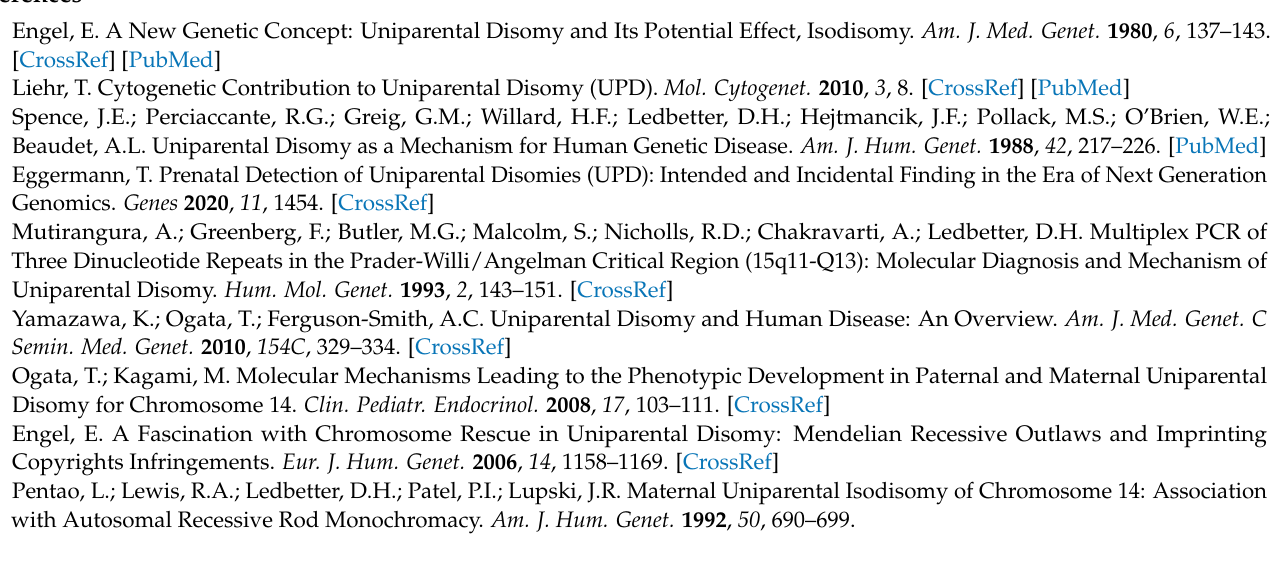
Figure S2: DNA sequence predicted by De novo assembly of the clipped reads. The AluY element insertion was predicted between the duplicated 11 bp segments (target site duplication). Table S1: Rare homozygous variants on chromosome 4 in patient 1. Table S2: Rare homozygous variants on chromosome 8 in patient